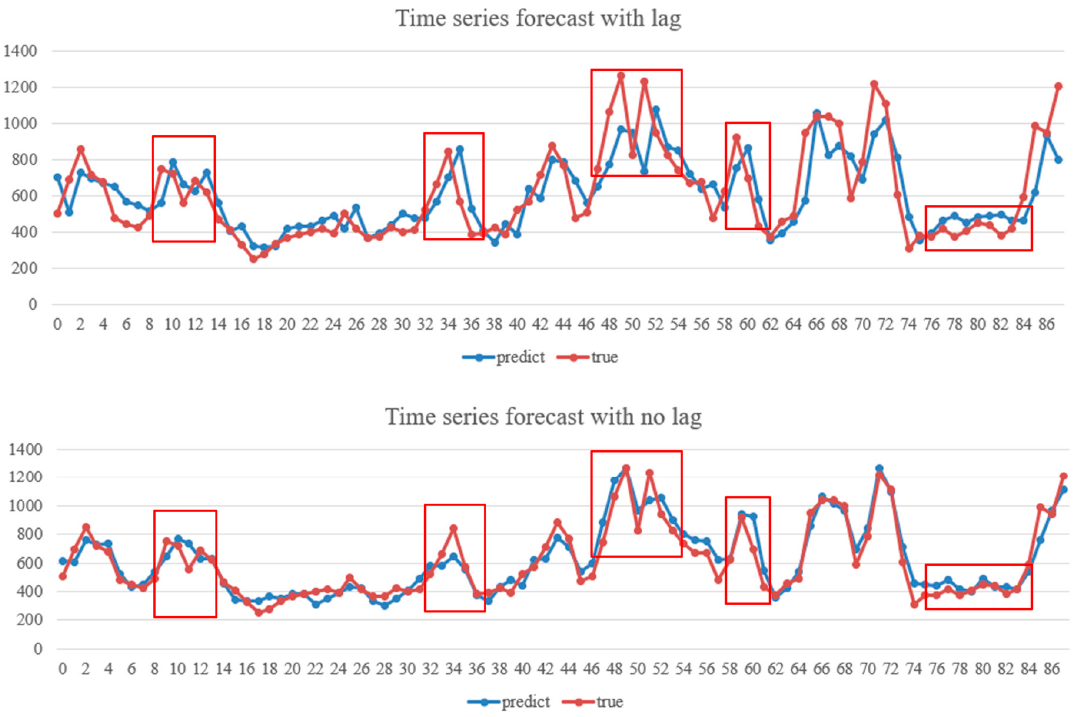
Figure 4. Result comparison of lag and no lag.